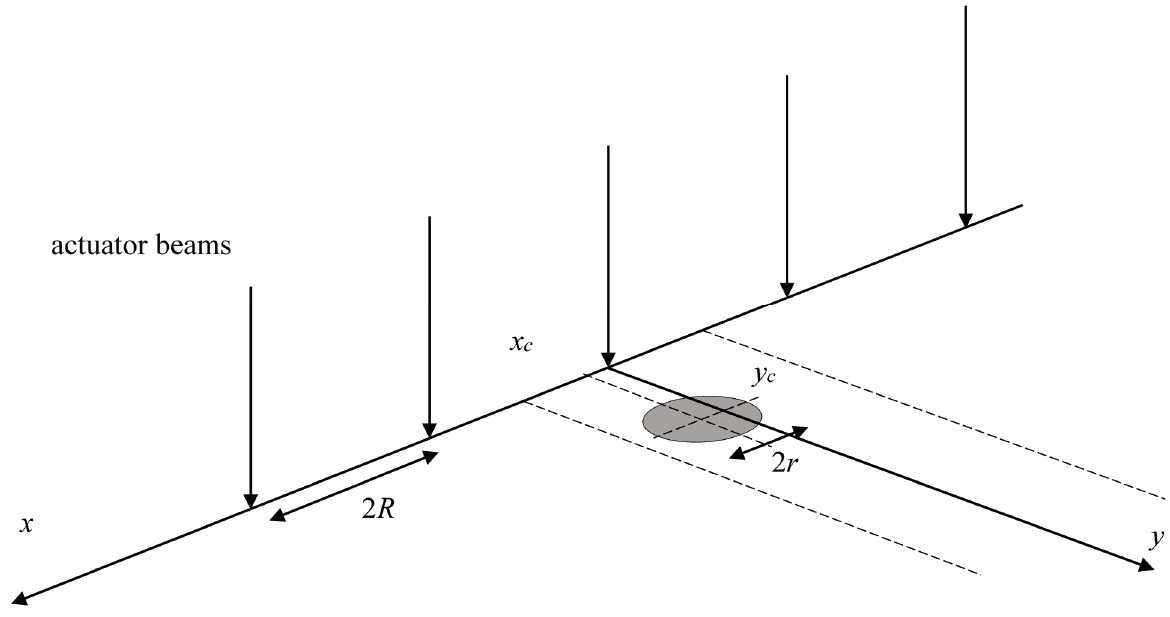
Figure 1. The geometry of evenly-spaced actuator beams and circular